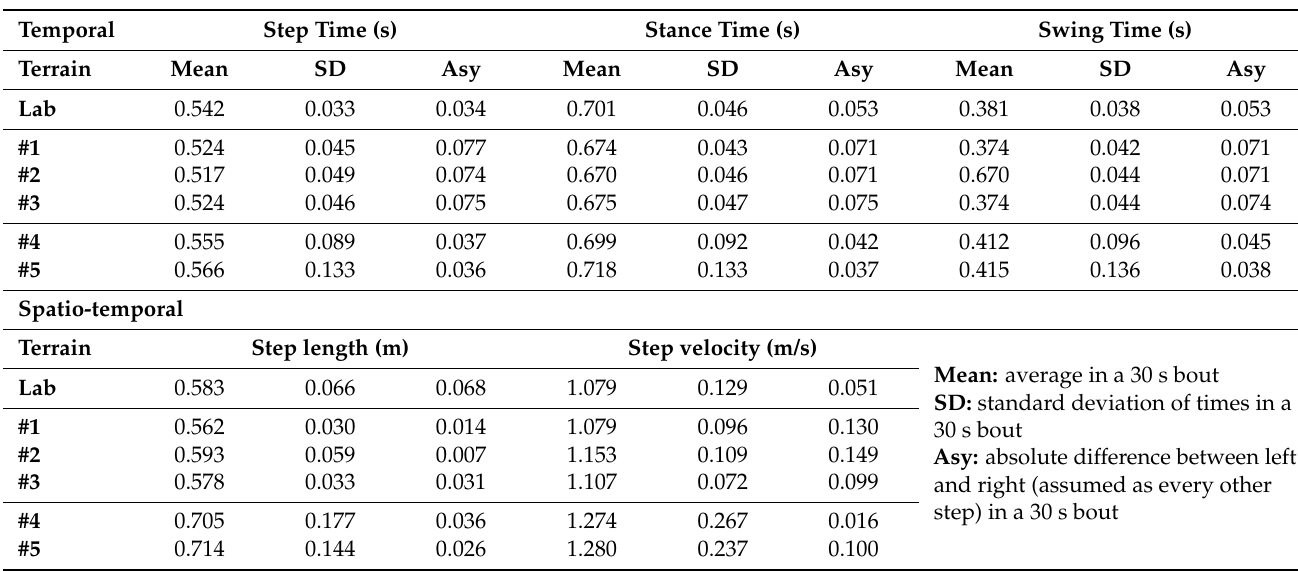
Table 1. Initial assessment of mobility/gait characteristics and terrain types over different 30 s bouts, no